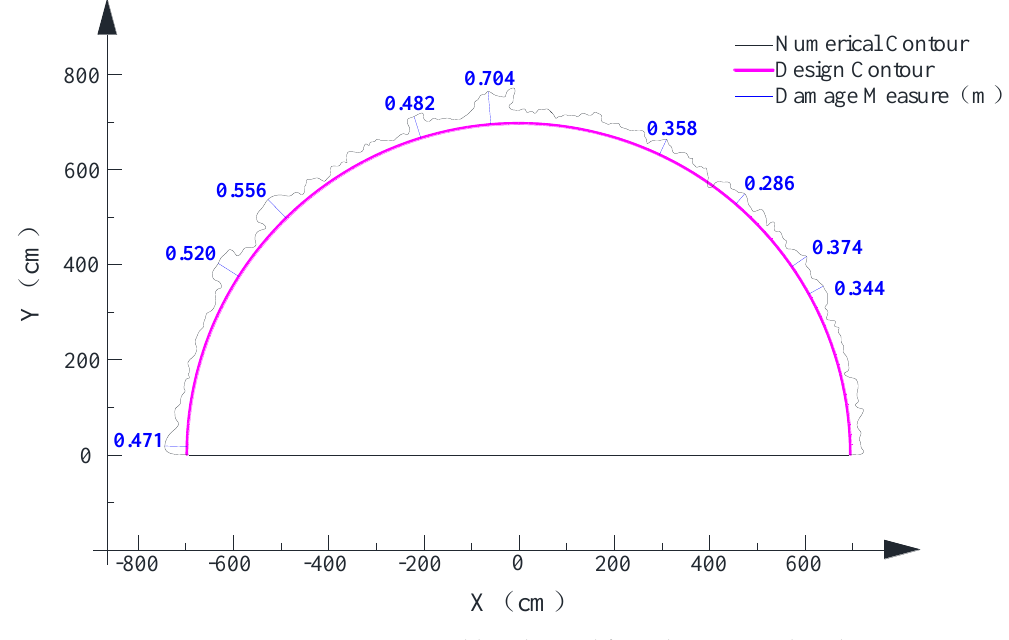
Figure 13. Damage contour in blue obtained from the numerical